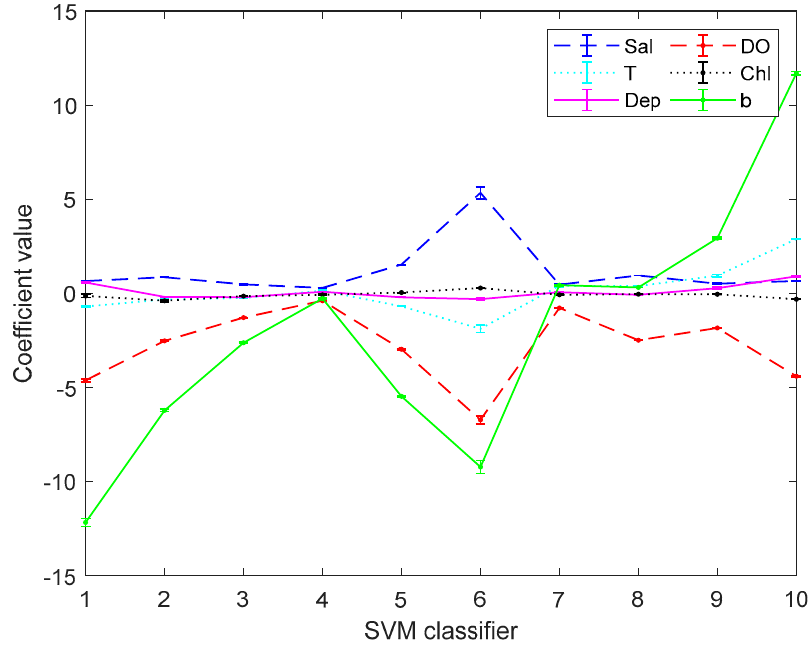
Figure 4. Classifiers by softmax regression after data preprocessing.